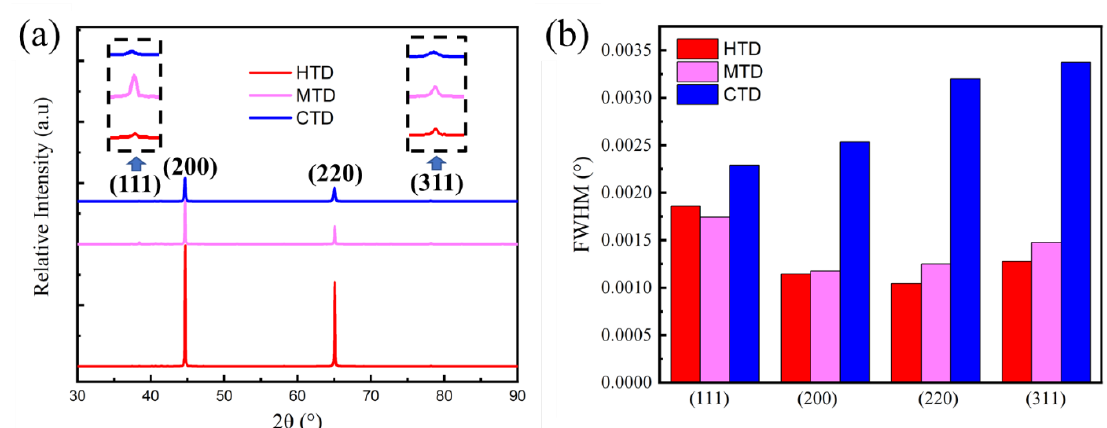
Figure 5. ( a ) XRD patterns and ( b ) FWHM values of the 7085 forged alloys.